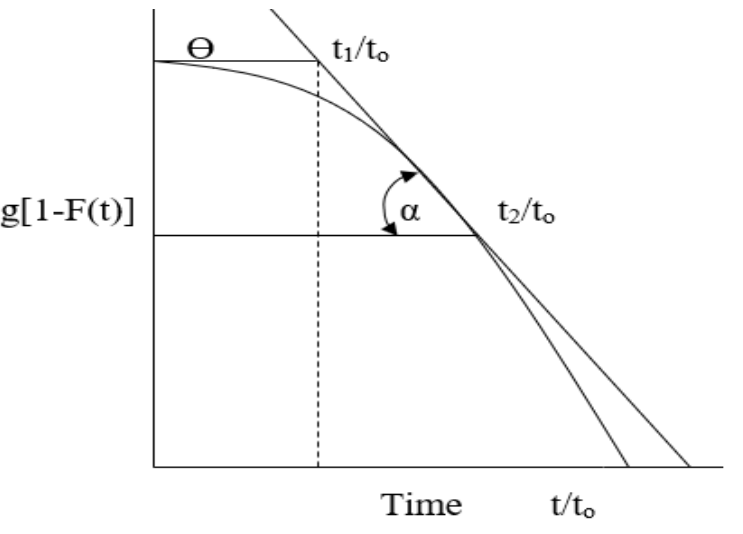
Figure 2. Curve of 1 − F(t) plotted to calculate α and θ .